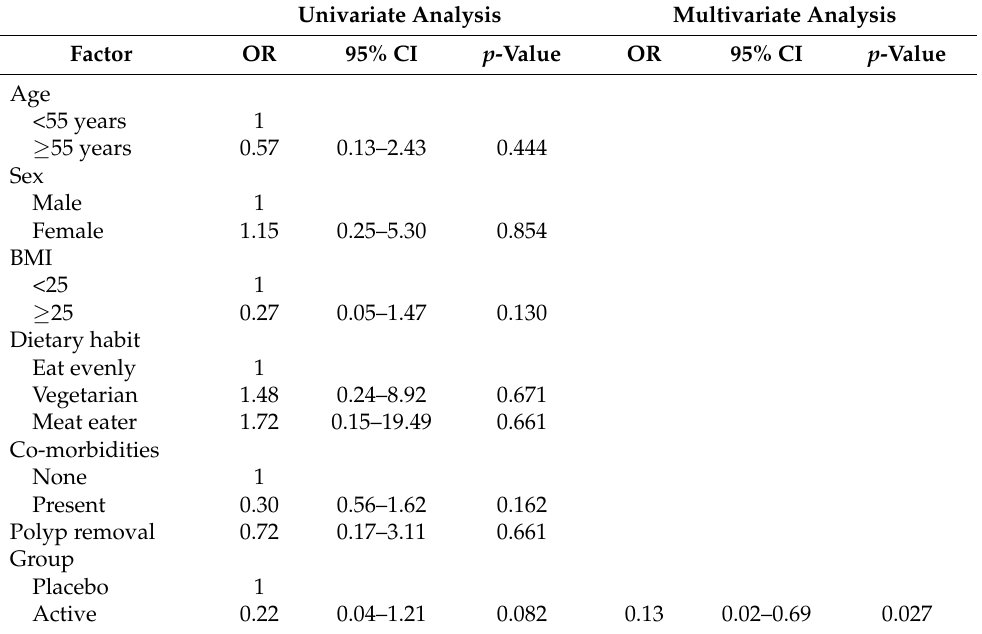
Table 3. Factors associated with complications (duration ≥ 1–2 h) after